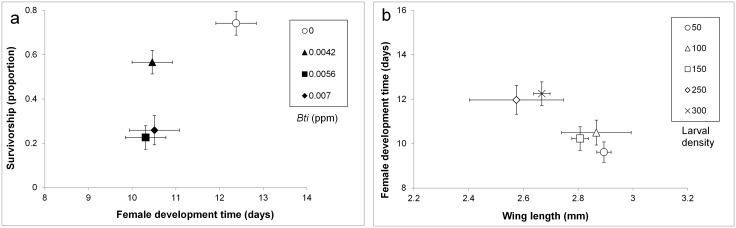
Bivariate plots of least-squares means (±SE) for three dependent variables for Aedes aegypti females.a) The effects of pesticide treatment on survivorship to adulthood and female development time. b) The effects of density treatment on wing length and female development time.